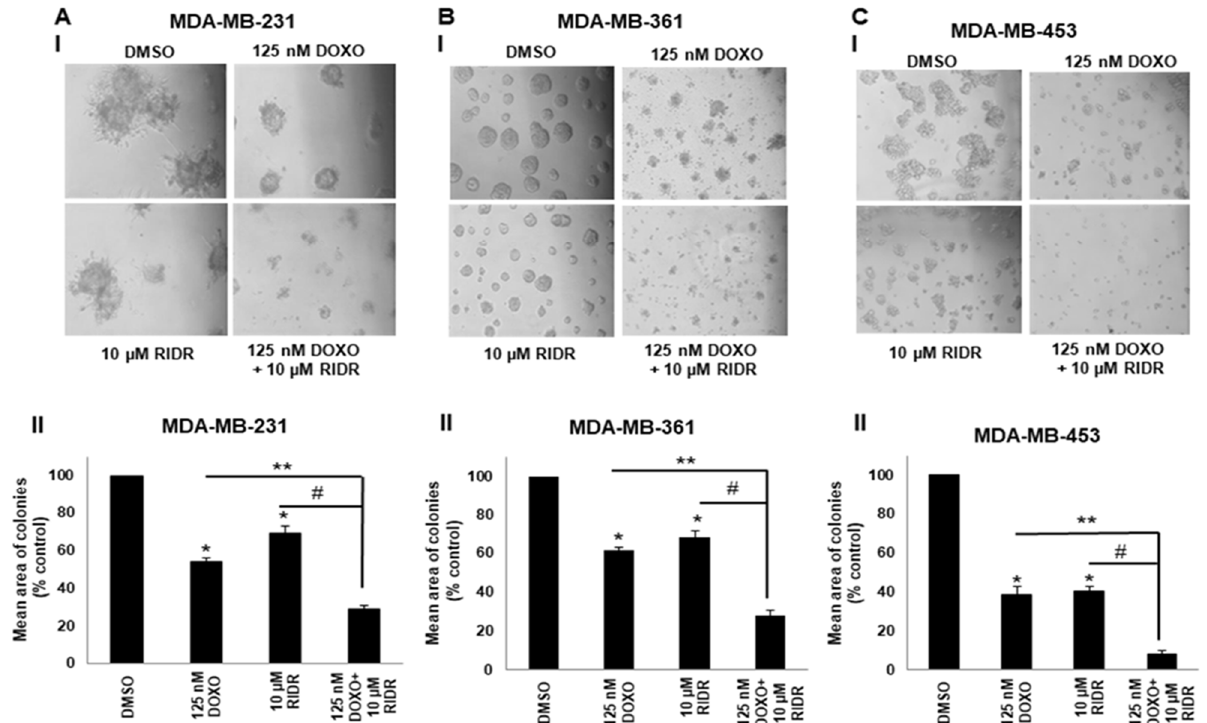
Figure 4. Doxorubicin and RIDR-PI-103 inhibit colony formation on matrigel. ( A ) MDA-MB-231 cells (2 × 10 4 cells/well) were seeded on a basement membrane of matrigel and treated with vehicle (DMSO), doxorubicin (125 nM), RIDR-PI-103 (10 µM) or combination every second day. ( B ) MDA-MB-361 cells (2 × 10 4 cells/well) were seeded on a basement membrane of matrigel and treated with vehicle (DMSO), doxorubicin (125 nM), RIDR-PI-103 (10 µM) or combination every second day. ( C ) Equal number of MDA-MB-453 cells were seeded on a basement membrane of matrigel and treated with vehicle (DMSO), doxorubicin (125 nM), RIDR-PI-103 (10 µM) or combination every second day. Phase contrast images of acini for all cell lines were captured at 10× magnification (panel I) and the average size of each cellular structure was quantified and expressed as mean of areas ± SEM, ( n = 3 independent experiments performed in triplicate). * p < 0.05 versus DMSO and **, # p < 0.01 versus respective treatment groups (panel II).